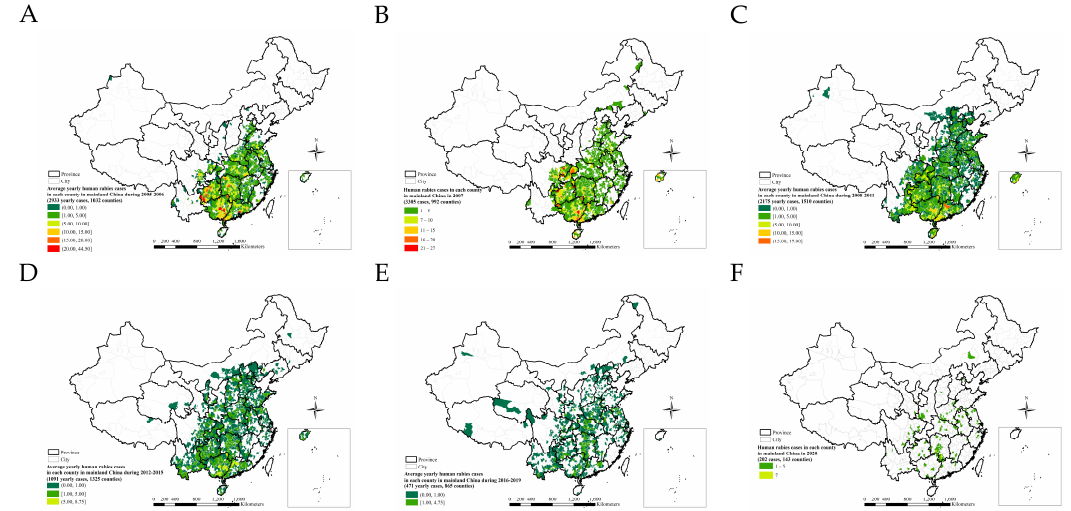
Figure 3. Phased spatial distribution of human rabies in mainland China, 2005–2020. ( A ) 2005–2006.